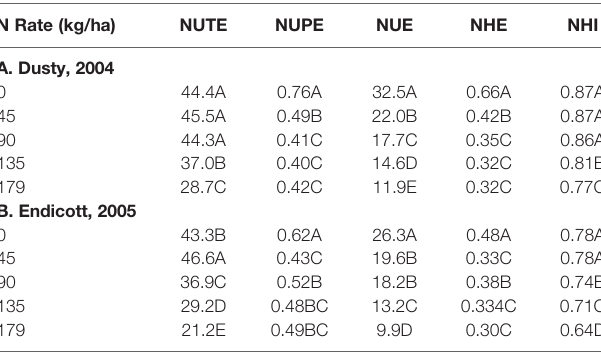
TABLE 4 | N rate means averaged over all genotypes for N utilization (NUTE), N uptake (NUPE), nitrogen use ef fi ciency (NUE), grain N harvest ef fi ciency (NHE), and N harvest index (NHI).